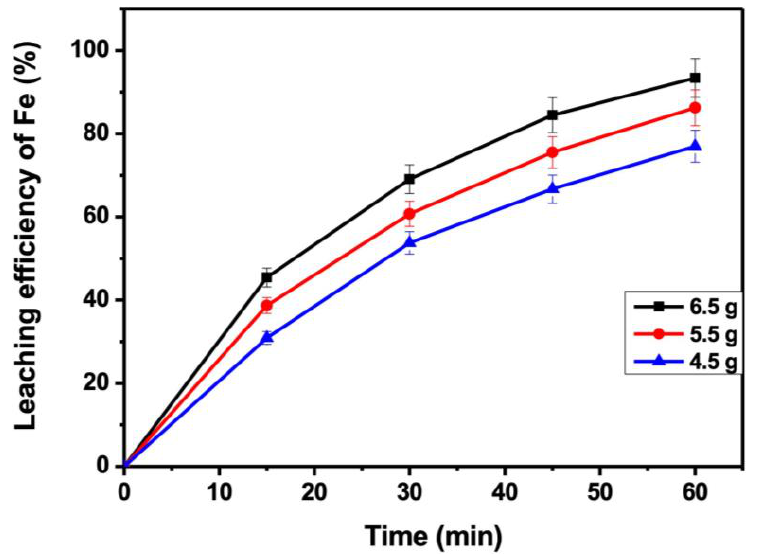
Figure 8. Effect of iron powder addition on the dissolution of Fe. Conditions: particle size, +150 µm; acid concentration, 7.5 M; solid – liquid ratio, 1:20; agitation speed, 450 rpm; temperature, 90 °C; agitation time, 60 min.